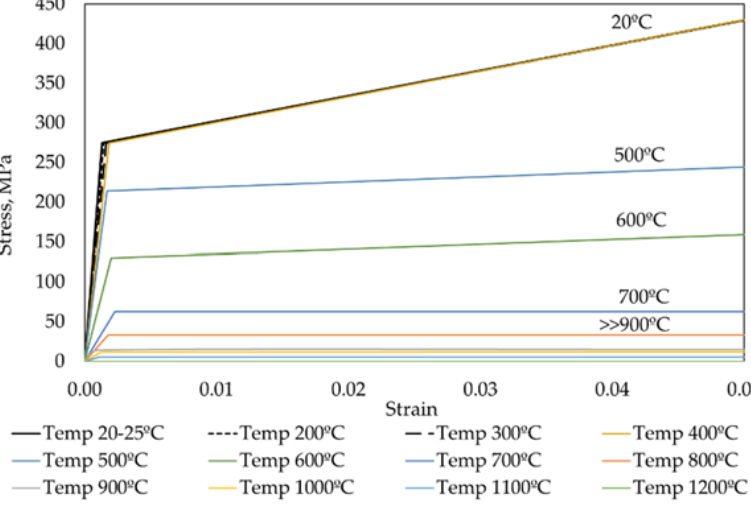
Figure 2. Strain–stress of steel at different temperatures.